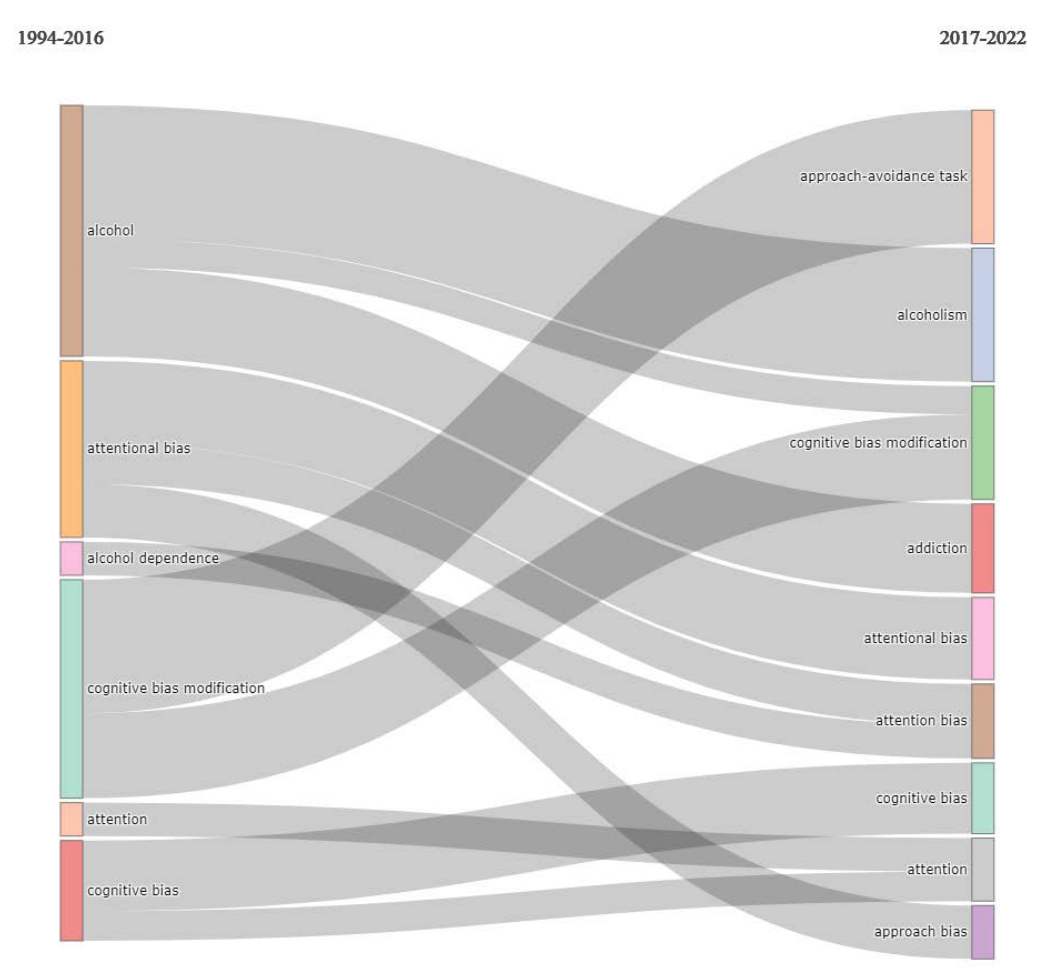
Figure 5. Thematic evolution of topics over the years.